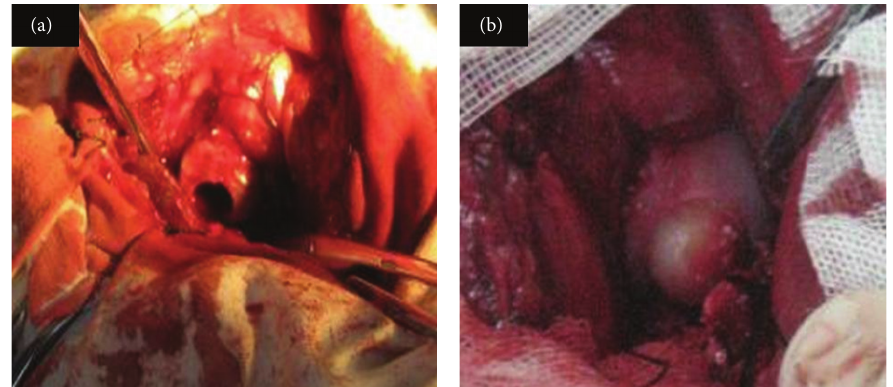
Figure 2: Implantation of the cell-scaffold complexities: (a) preparation of osteochondral defects in high-load-bearing area of canine femoral head and (b) osteochondral